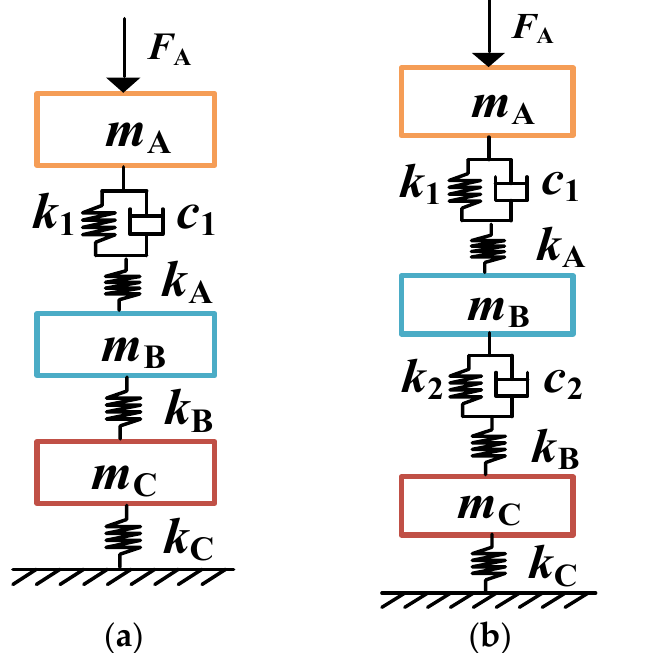
Figure 4. Simplified structures of the AUG with ( a ) the single-stage vibration isolator and ( b ) the two-stage vibration isolator.